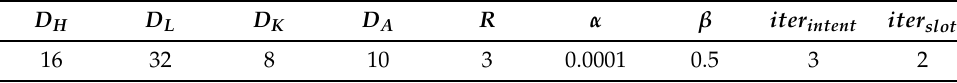
Table 1. Hyperparameter values.